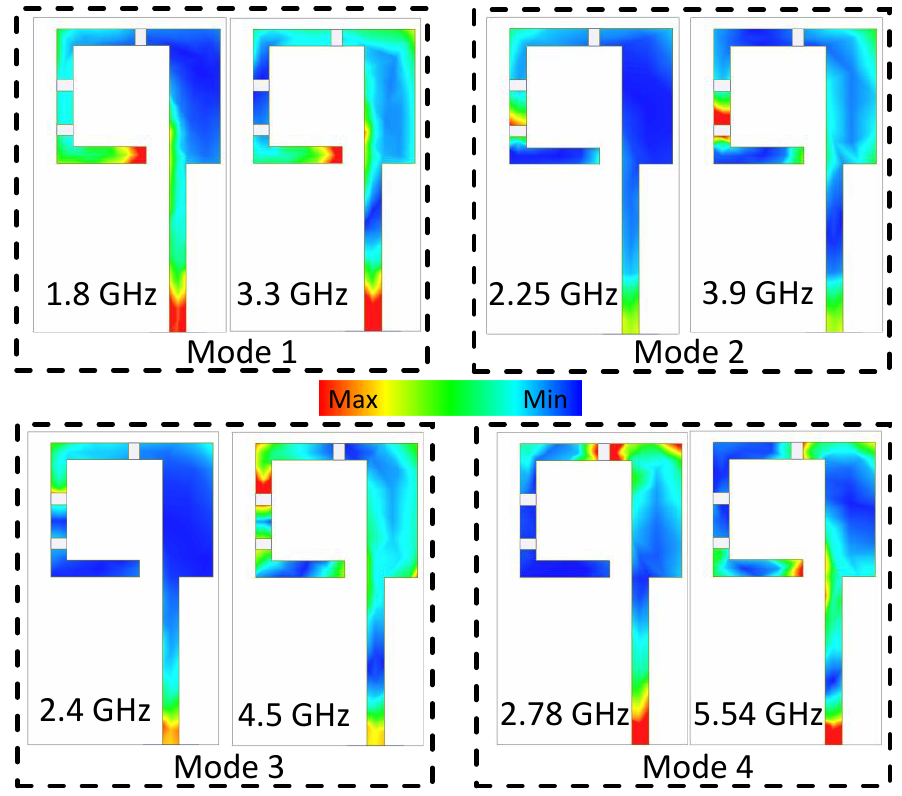
Figure 4. Surface current distribution of the antenna for different operating